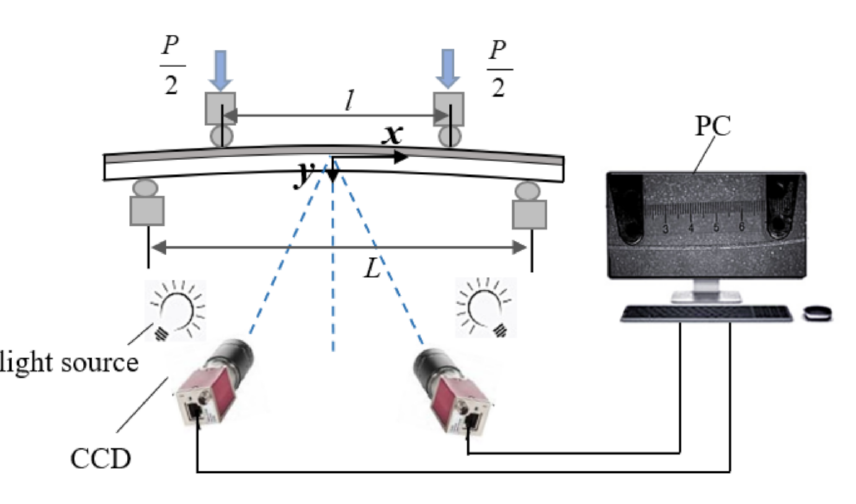
Figure 6. Schematic diagram of a 3D DIC system for cross sectional profile measurement of four-point bending